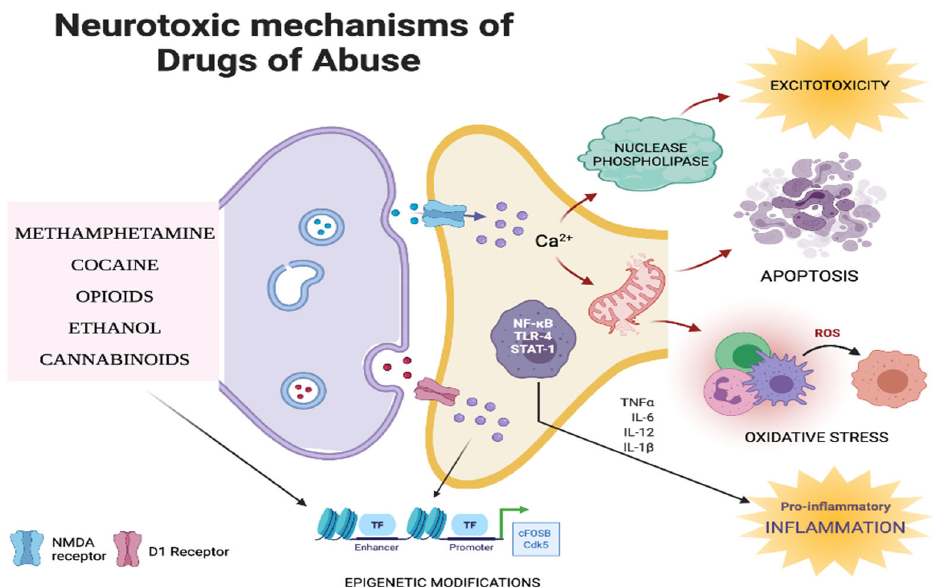
Figure 2. Outline of neurotoxic mechanisms of various drugs of abuse. Various drugs of abuse over ‐ activate the glutamatergic and/or dopaminergic signaling pathways and initiate molecular cascades leading to excitotoxicity, apoptosis, oxidative stress, and inflammation. The figure was created using BioRender software.